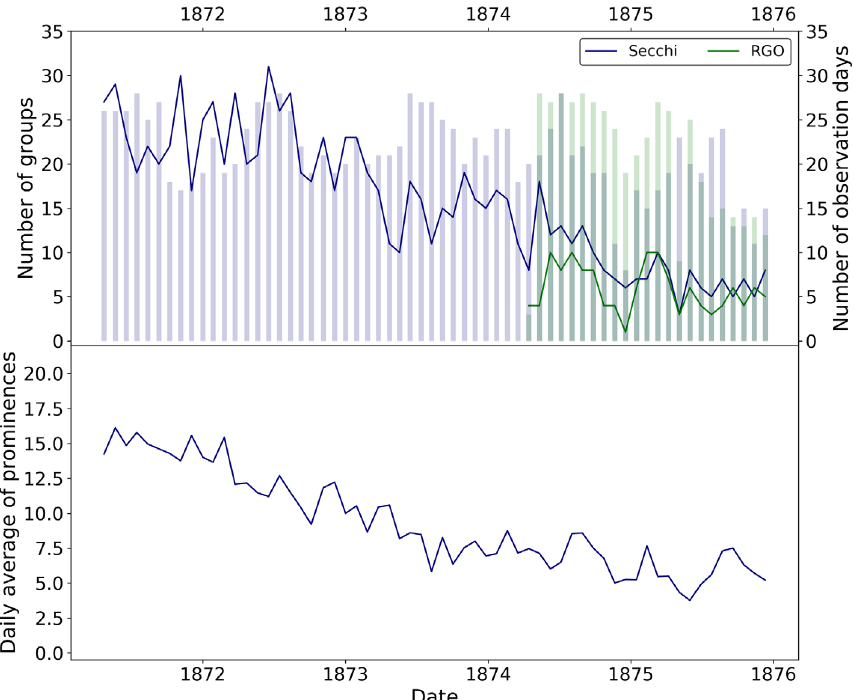
Fig. 4. Top panel: number of groups in each rotation (blue line) recorded by Secchi for the period 1871 – 1875 and the same from the RGO (green line). Blue and green bars depict the number of observations in each solar rotation by Secchi and RGO, respectively. Bottom panel: daily average of the number of prominences in each solar rotation for the same period.